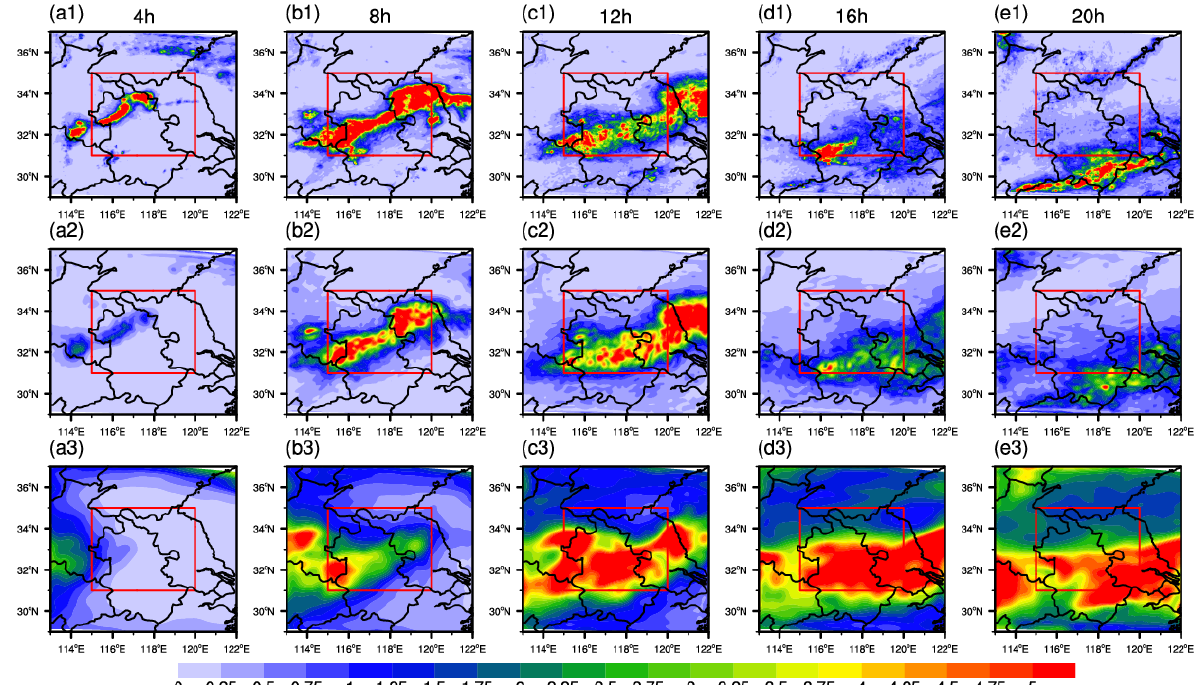
Figure 11. Distribution maps of RMDTE in the SF case at ( a1 – e1 ) the small scale, ( a2 – e2 ) medium scale, and ( a3 – e3 ) large scale for ( a1 – a3 ) 4-h, ( b1 – b3 ) 8-h, ( c1 – c3 ) 12-h, ( d1 – d3 ) 16-h, and ( e1 – e3 ) 20-h forecasts. The red square marks the major precipitation area.